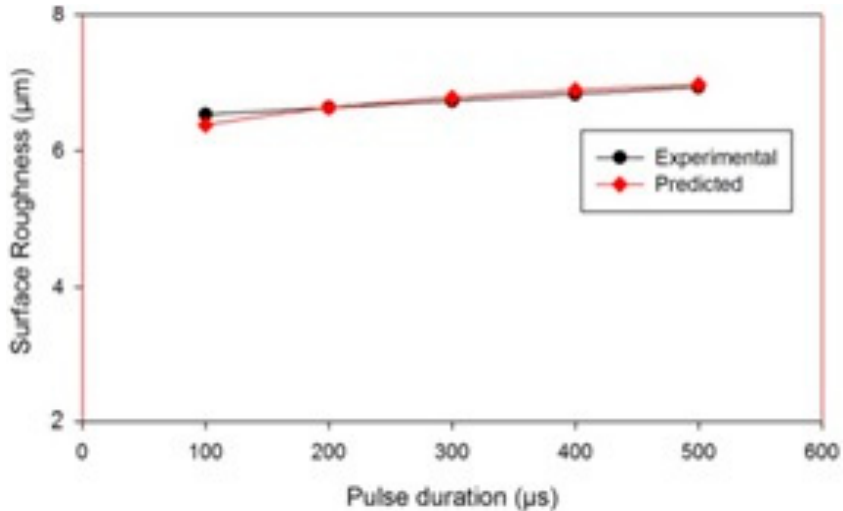
Figure 8. Variation in Surface Roughness with pulse duration.